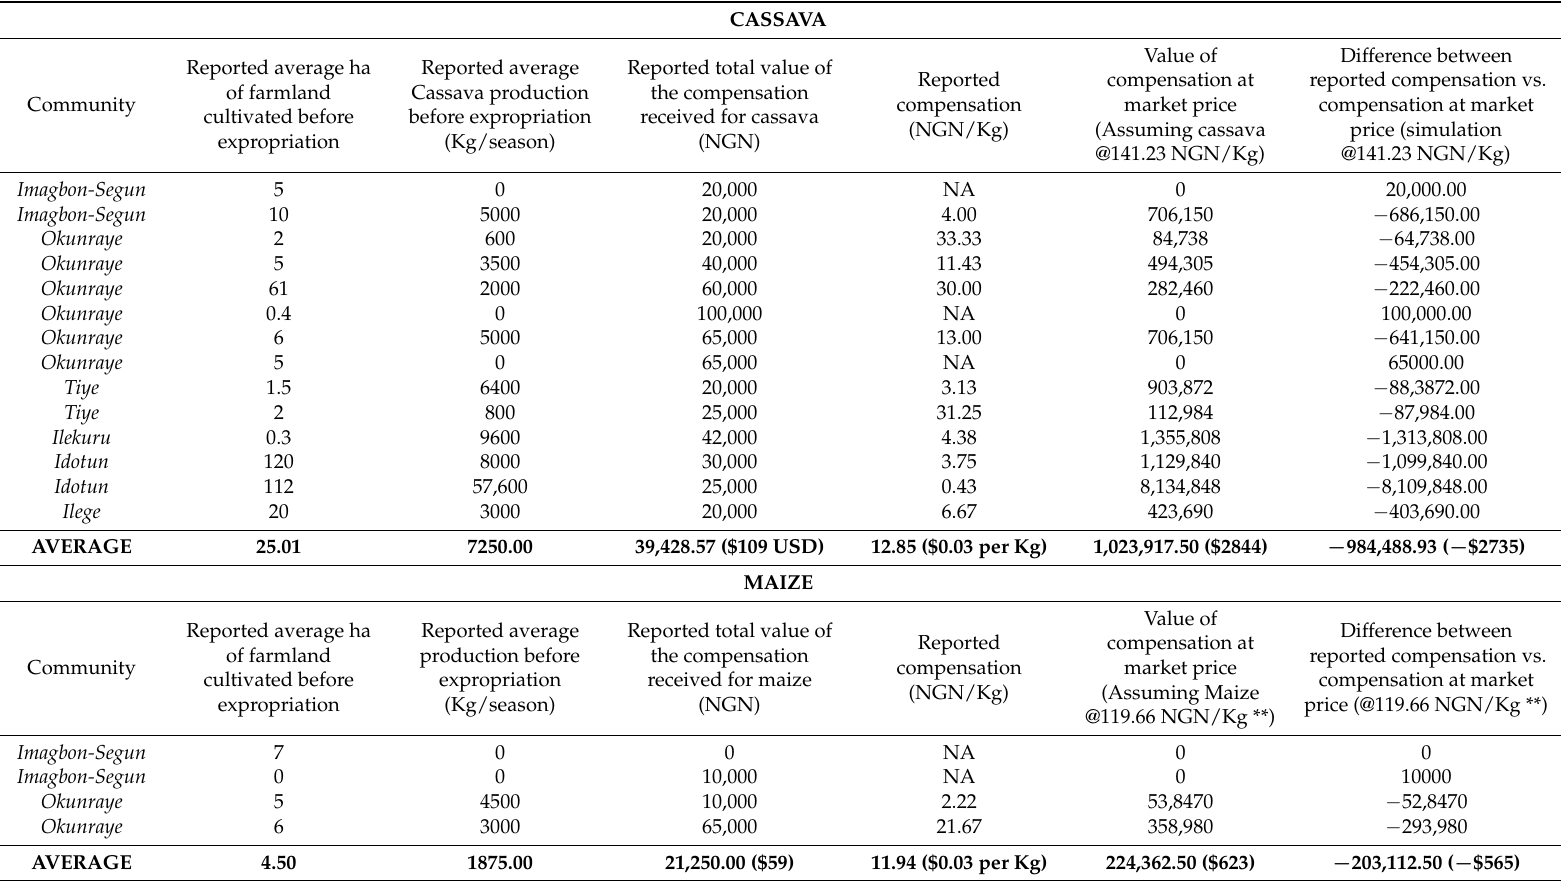
Table 9. Reported compensation for selected crops and estimates of compensation at market